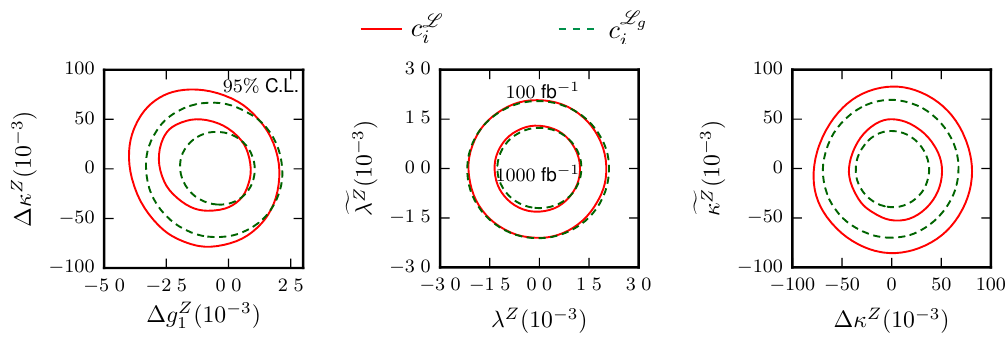
Figure 9 . The marginalised 2 D projections at 95 % BCI from MCMC in the (cid:1) g Z (cid:21) Z , and (cid:1) (cid:20) Z - (cid:20) Z planes are shown in solid /red when the e(cid:11)ective vertex factors ( c L independent, while shown in dashed /green when the operators are treated independent ( c f f luminosities L = 1000 fb (cid:0) 1 (two inner contours) and L = 100 fb (cid:0) 1 (two outer contours) at p s = 13 TeV using all the observables.